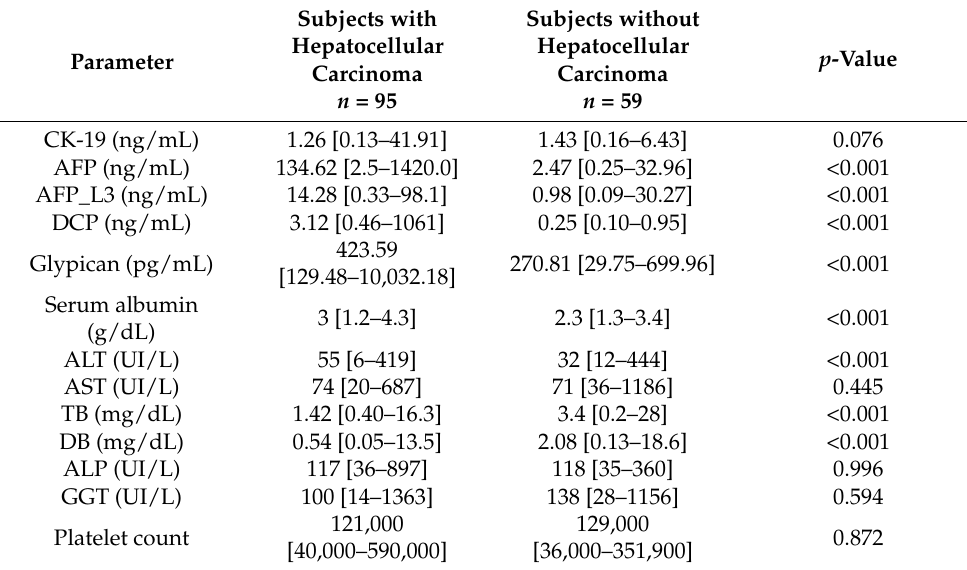
Table 2. Laboratory results.